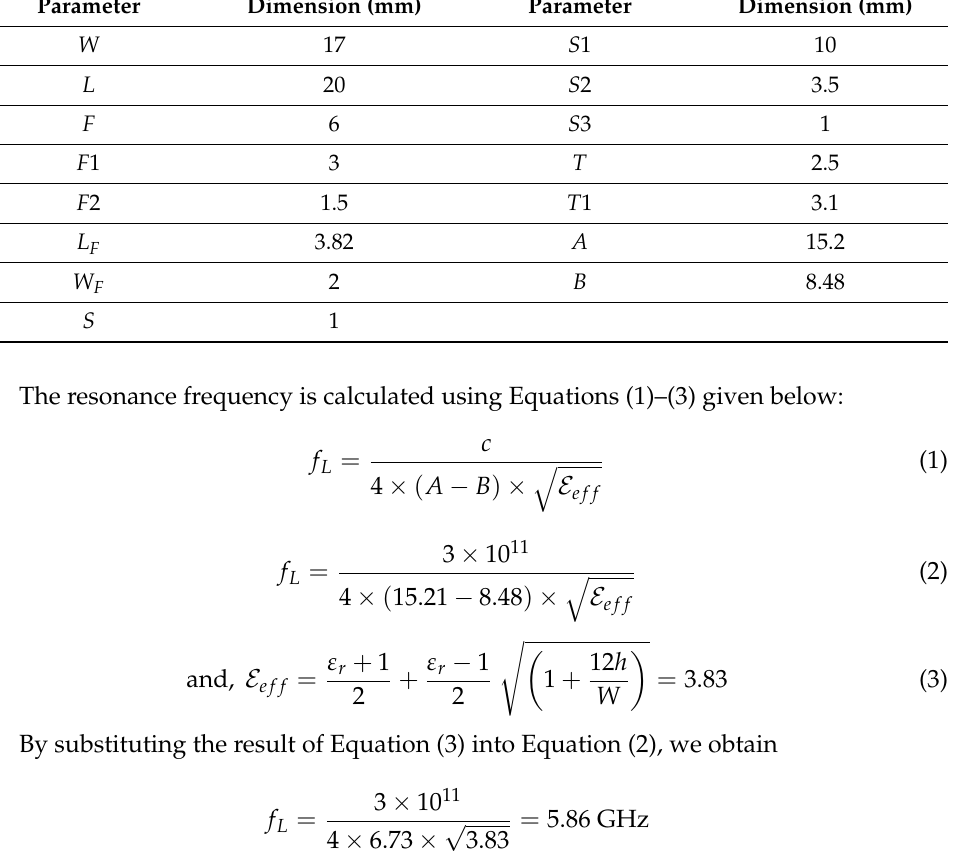
Figure 5. S 11 features of the evolution stages. 2.2. Ground Plane Truncation Effect The modification process of the ground plane during its development stage is de- picted in Figure 6, where the S11 characteristics were graphed for each step. It was ob- served that iteration C of the proposed antenna had better S11 bandwidth below − 10 dB and impedance matching compared to iterations A and B. The results of the S11 analysis are displayed in Figure 7.